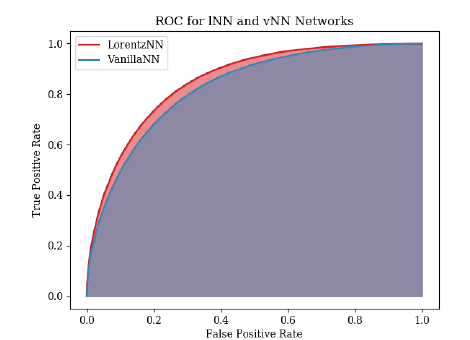
Figure 5. ROC curves for the Vanilla and Lorentz networks. The red curve shows a small but clear performance gain for the Lorentz network.